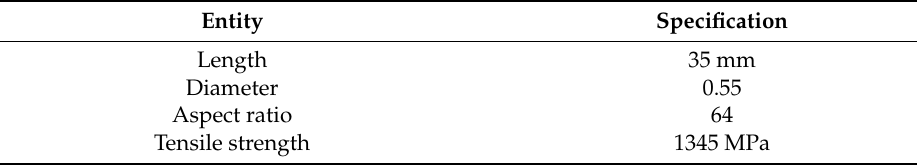
Table 5. The specifications of hooked end steel fibers.